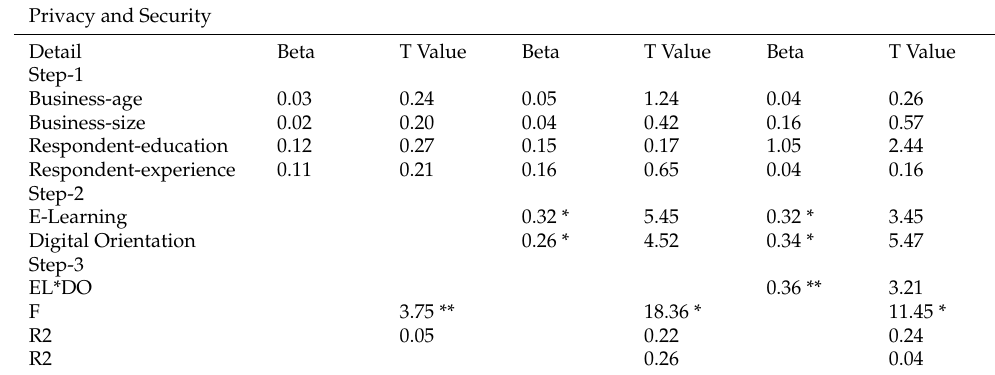
Table 6. Hierarchal regression outcomes for moderating influence of Digital